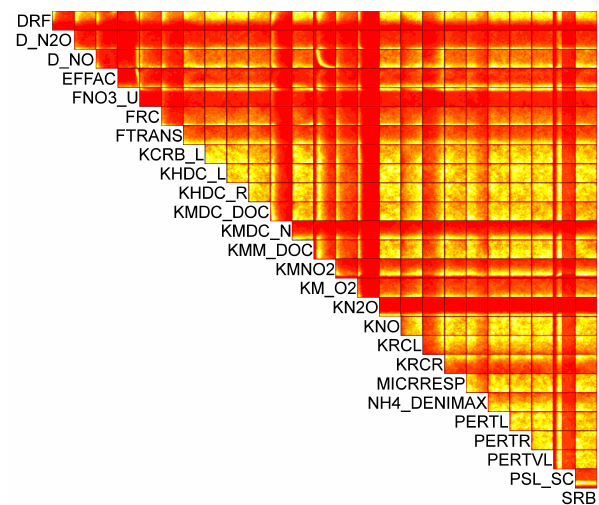
Fig. 9. Heat-maps of pair-wise marginal distributions; brighter poly- gons show higher posterior